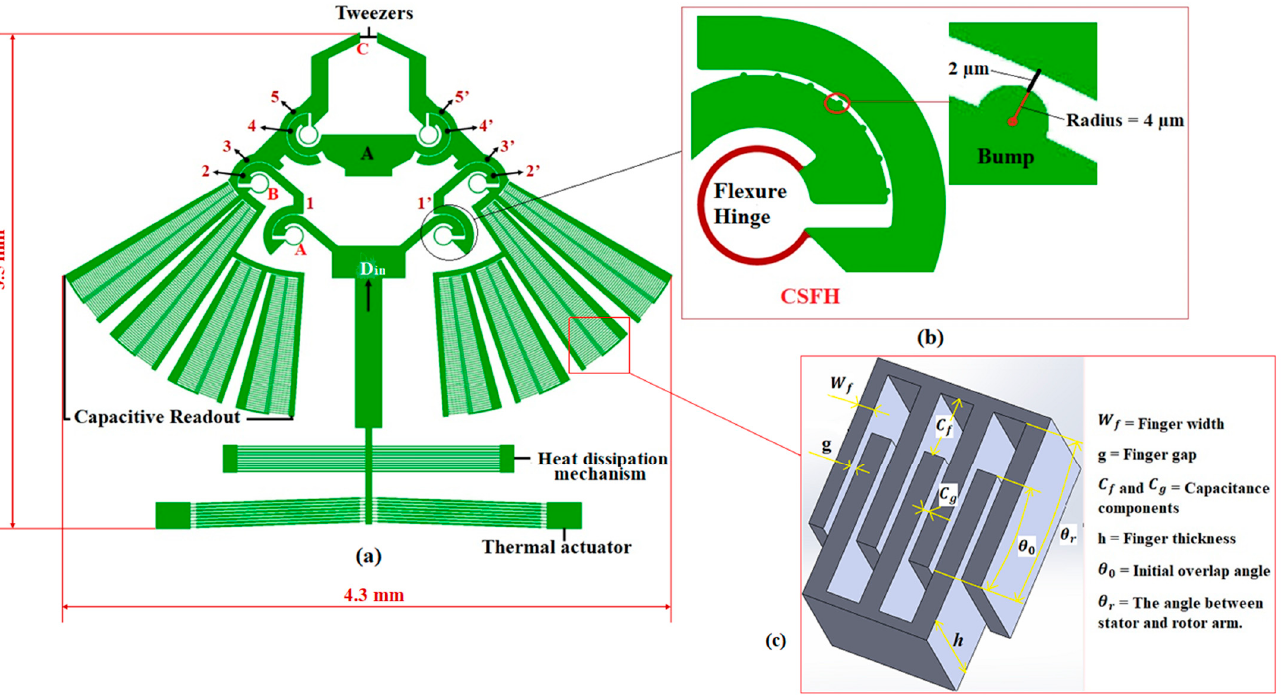
Figure 1. ( a ) Microgripper model with all its main components; ( b ) layout of a conjugate surface flexure hinge (CSFH) with a series of bump-shaped structures; ( c ) capacitive readout.